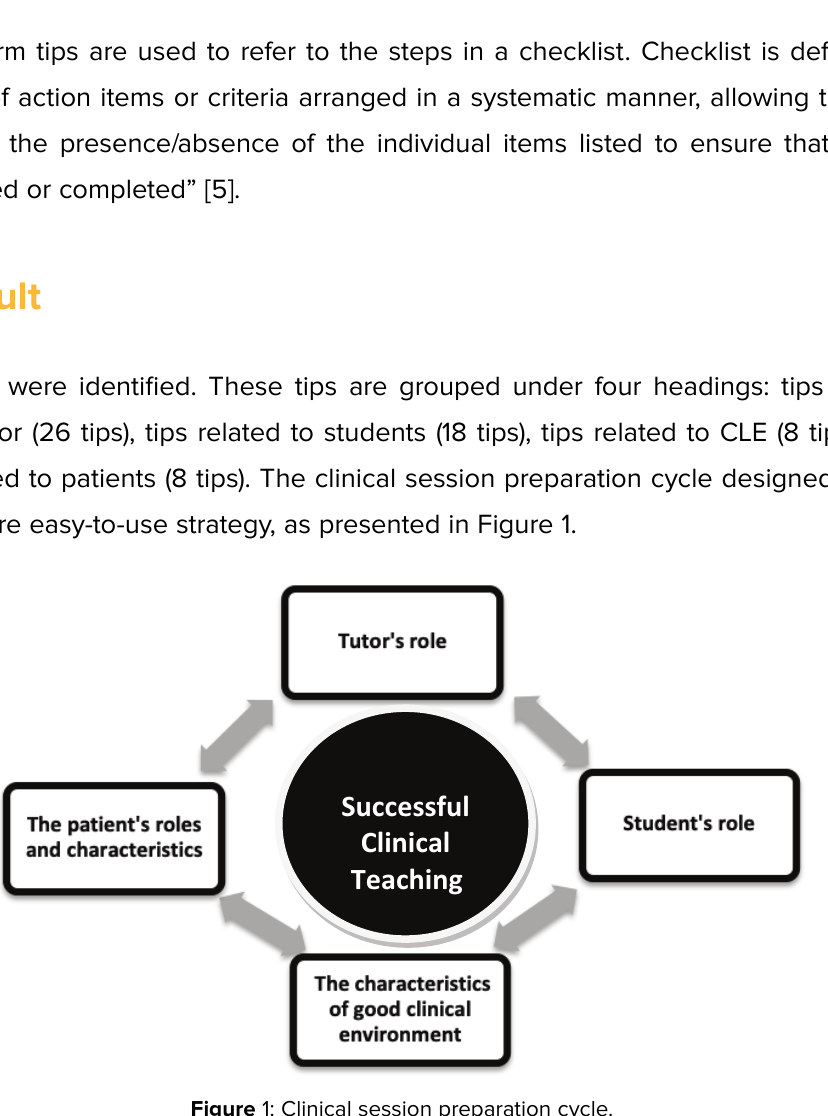
Figure 1: Clinical session preparation